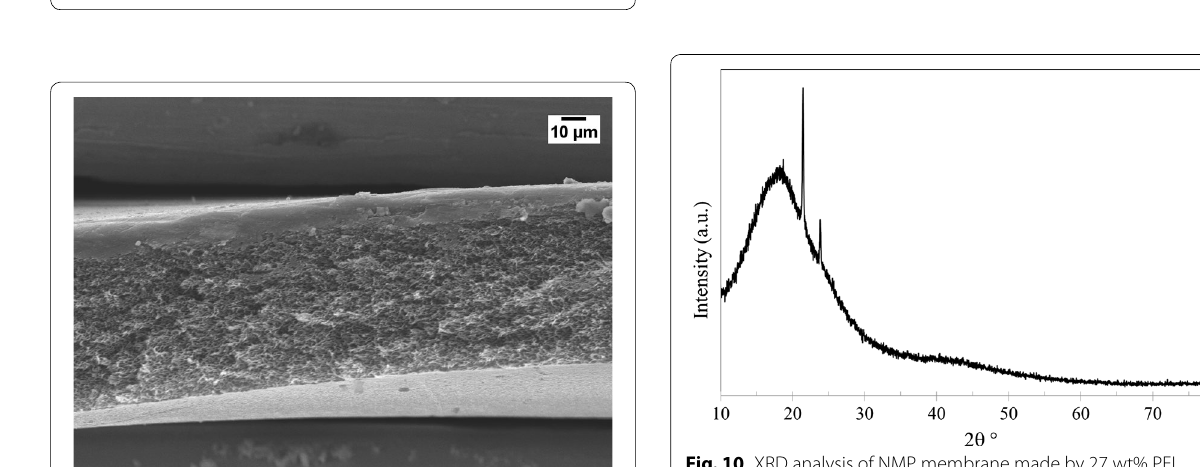
Fig. 7 Cross‑section image of GBL membrane made by 23 wt% PEI